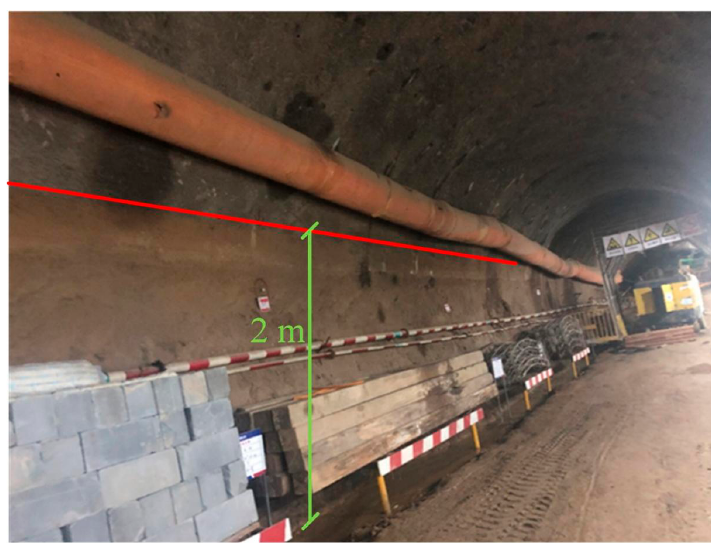
Figure 7. Tunnel after cleaning.